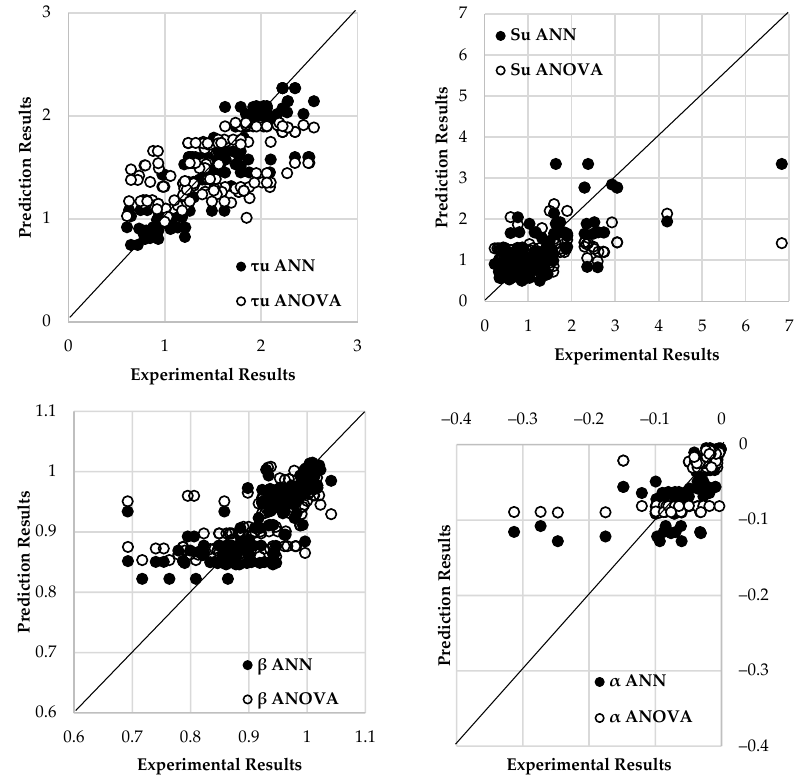
Figure 2. Predicted parameters using ANN and ANOVA vs. experimental results for circular specimens.